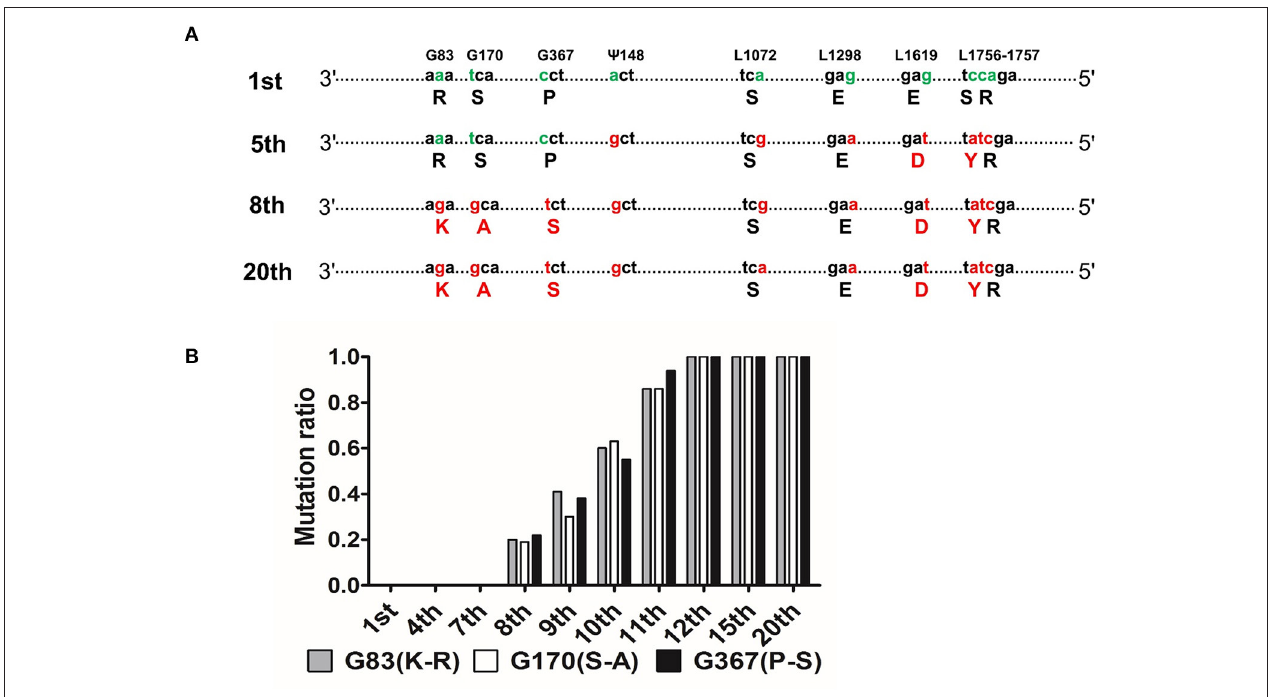
FIGURE 2 | Comparison of genomic nucleotides between the different passages of CNIM1701. (A) Schematic diagram of sequence variations between different passages of CNIM1701. Green characters stand for the original AAs and the red characters stand for the mutant AAs that changed after passage in mouse brain. (B) Each generation of the whole genome was sequenced 5 times, and the proportion of mutation sites happened in each generation of the virus.